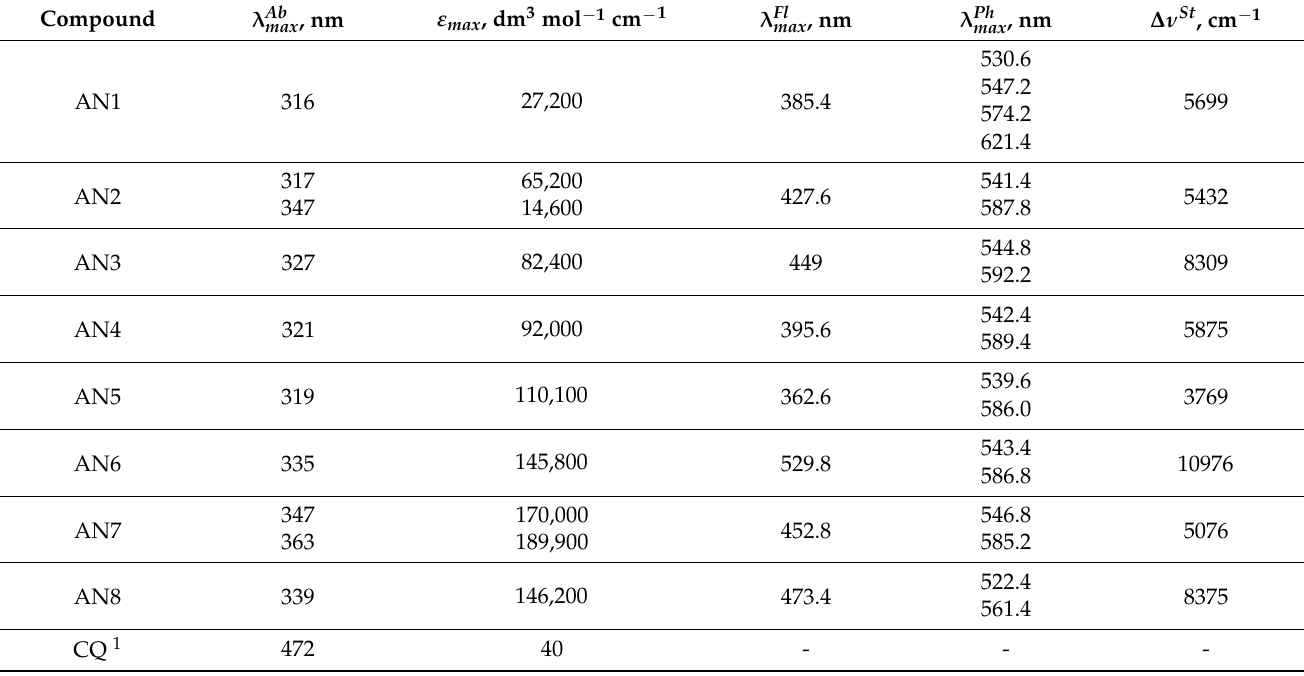
Table 1. Basic spectroscopic properties for the dyes tested in